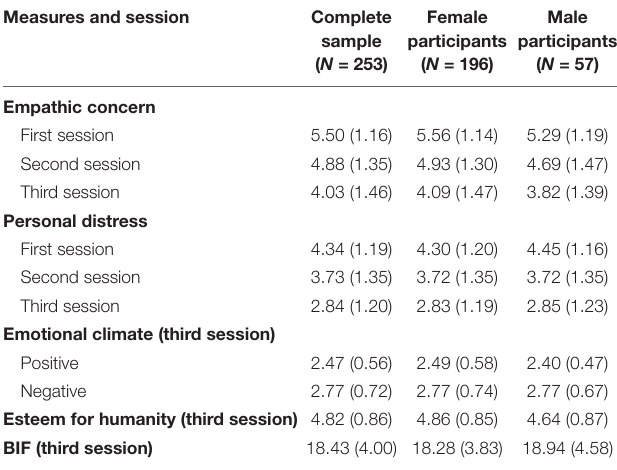
TABLE 1 | Descriptive statistics: means